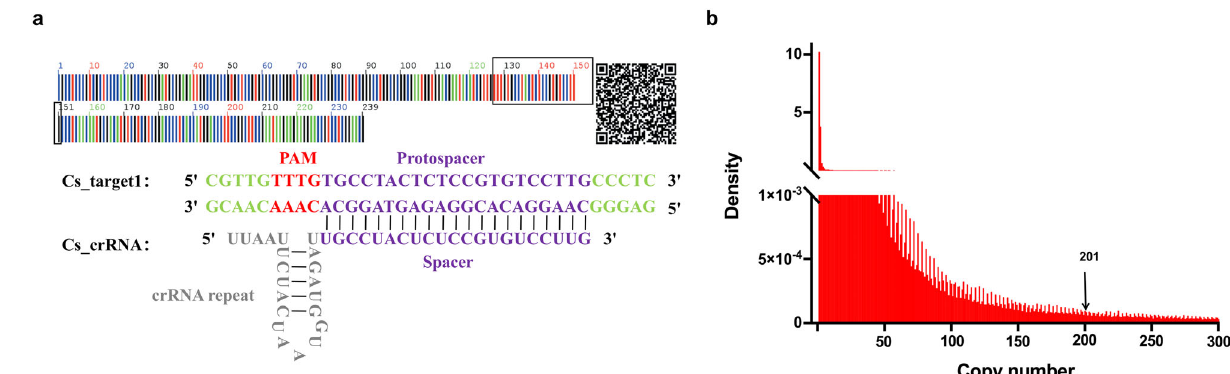
Fig. 2 Targets in ITS2 region of Crocus sativus . a Target sequence located in ITS2 region of Crocus sativus , Cs_target1 and its crRNA, Cs_crRNA. The red sequence is PAM and purple sequence is protospacer in Cs_target1; The gray sequence is the universal sequence of crRNA for LbaCas12a and purple sequence is spacer in Cs_crRNA. b Density of Targets ’ copy numbers ranging from 1 to 300 in Cr. sativus . Cs_target1 has 201 copies in the genome ( a ).